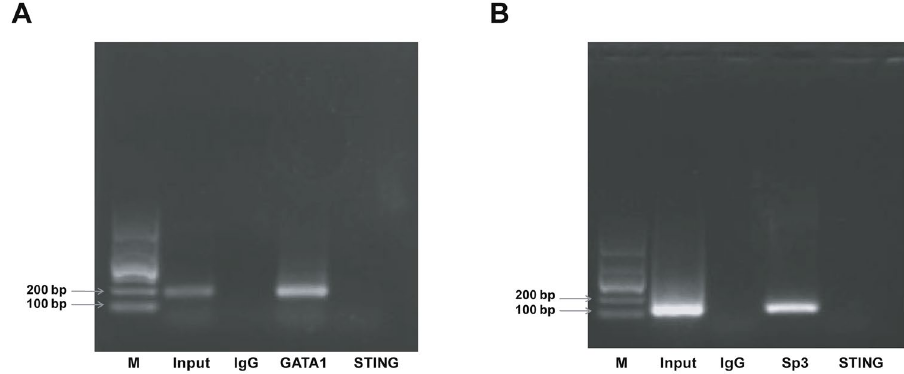
Figure 6. ChIP assay of the mSTING proximal promoter was performed in NIH3T3 cells. The immunoprecipitated chromatin fragments were analyzed by semi-quantitative PCR using primer pairs spanning the putative GATA1 and Sp1 binding site (the target locus) or exon 6 of the mSTING (a non-target locus). ( A ) GATA1 bound to the mSTING promoter in vivo . A band of 199 nt containing the GATA1 binding site in the mSTING promoter region was amplified. Lane M: DNA marker 1000. Lane INPUT: PCR product derived by ChIP-GATA1 primers from direct input DNA template without immunoprecipitation. Lane IgG: PCR product derived by ChIP-GATA1 primers from DNA template immunoprecipitated by normal IgG as a negative control. Lane GATA1: PCR product derived by ChIP-GATA1 primers from DNA template immunoprecipitated by anti-GATA1 antibody. Lane STING: PCR product derived by primers flanking exon 6 of the mSTING from DNA template immunoprecipitated by anti-GATA1 antibody. ( B ) Sp3 bound to the mSTING promoter in vivo . A band of 107 nt containing Sp3 binding site in the mSTING promoter region was amplified. Lane M: DNA marker 1000. Lane INPUT: PCR product derived by ChIP-Sp3 primers from direct input DNA template without immunoprecipitation. Lane IgG: PCR product derived by ChIP-Sp3 primers from DNA template immunoprecipitated by normal IgG as a negative control. Lane Sp3: PCR product derived by ChIP-Sp3 primers from DNA template immunoprecipitated by anti-Sp3 antibody. Lane STING: PCR product derived by primers flanking exon 6 of them STING from DNA template immunoprecipitated by anti-Sp3